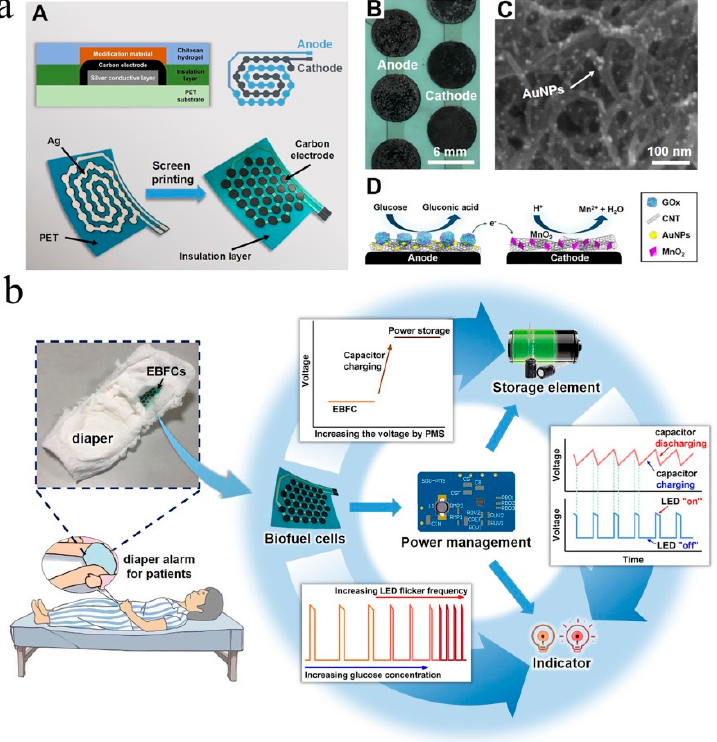
Figure 8. ( a ) Schematic diagram ( A ), electrode material characterization ( B , C ), and the working principle of the diaper µ -EBFC-SPB ( D ); ( b ) detailed view of the components of the diaper alarm and the circuit diagram of alarm device [62]. Copyright 2021 Elsevier.